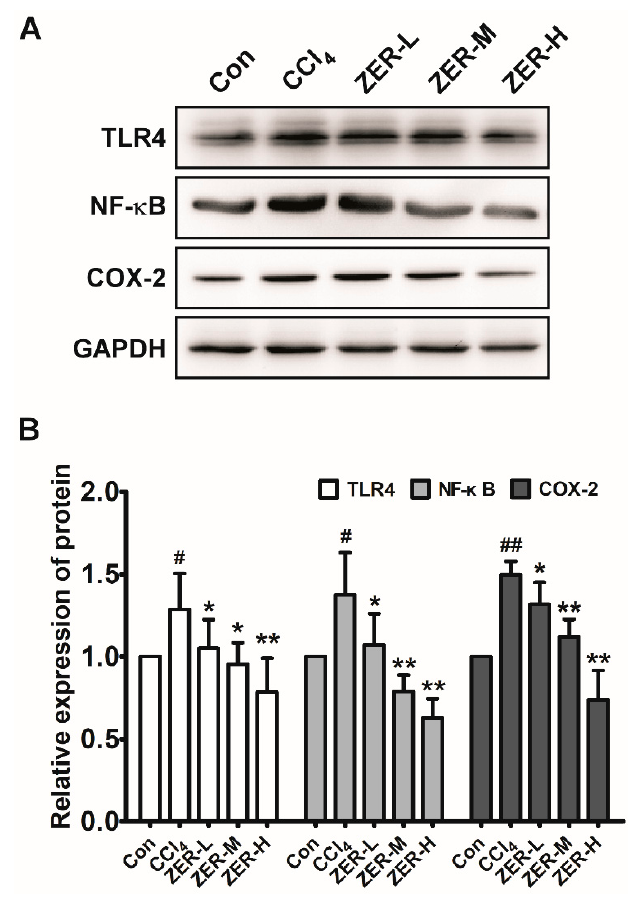
Figure 5. Effects of ZER on the protein levels of TLR4, NF- κ B (p-p65), and COX-2 in liver tissue of CCl 4 -induced ALI mice. ( A ) Western blotting analysis of TLR4, NF- κ B (p-p65), and COX-2; Glyceraldehyde-3-phosphate dehydrogenase (GAPDH) was used as the loading control. ( B ) Quantification of the relative protein levels of TLR4, NF- κ B (p-p65), and COX-2. Values represent the mean ± SD ( n = 3). # p < 0.05 and ## p < 0.01 compared with the control group; * p < 0.05 and ** p < 0.01 compared with the CCl 4 -treated